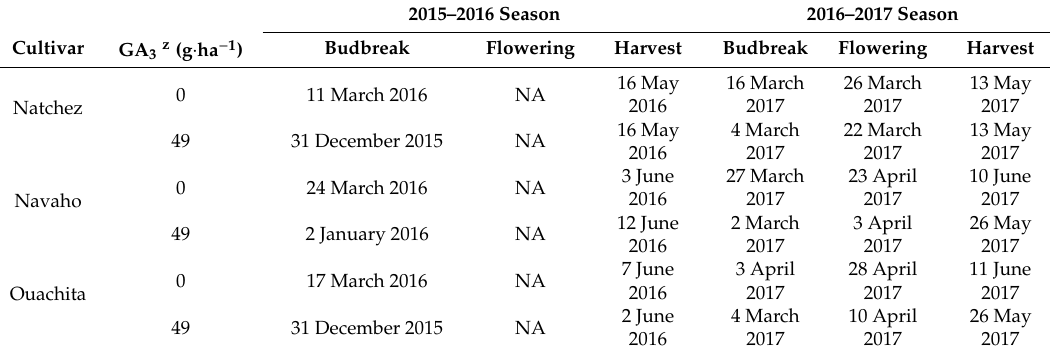
Table 1. Onset of budbreak, flowering, and harvest of ‘Natchez’, ‘Navaho’, and ‘Ouachita’ blackberry grown under subtropical climatic conditions as a ff ected by gibberellic acid (GA 3 ) treatment in